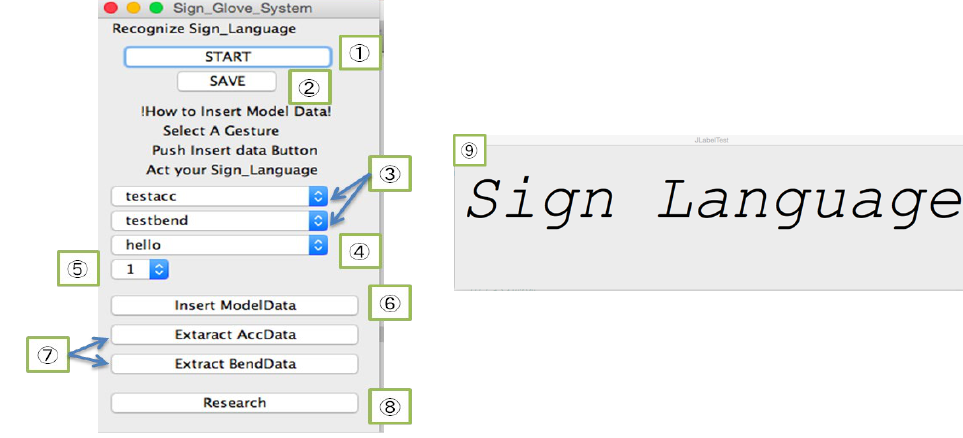
Figure 8. System user